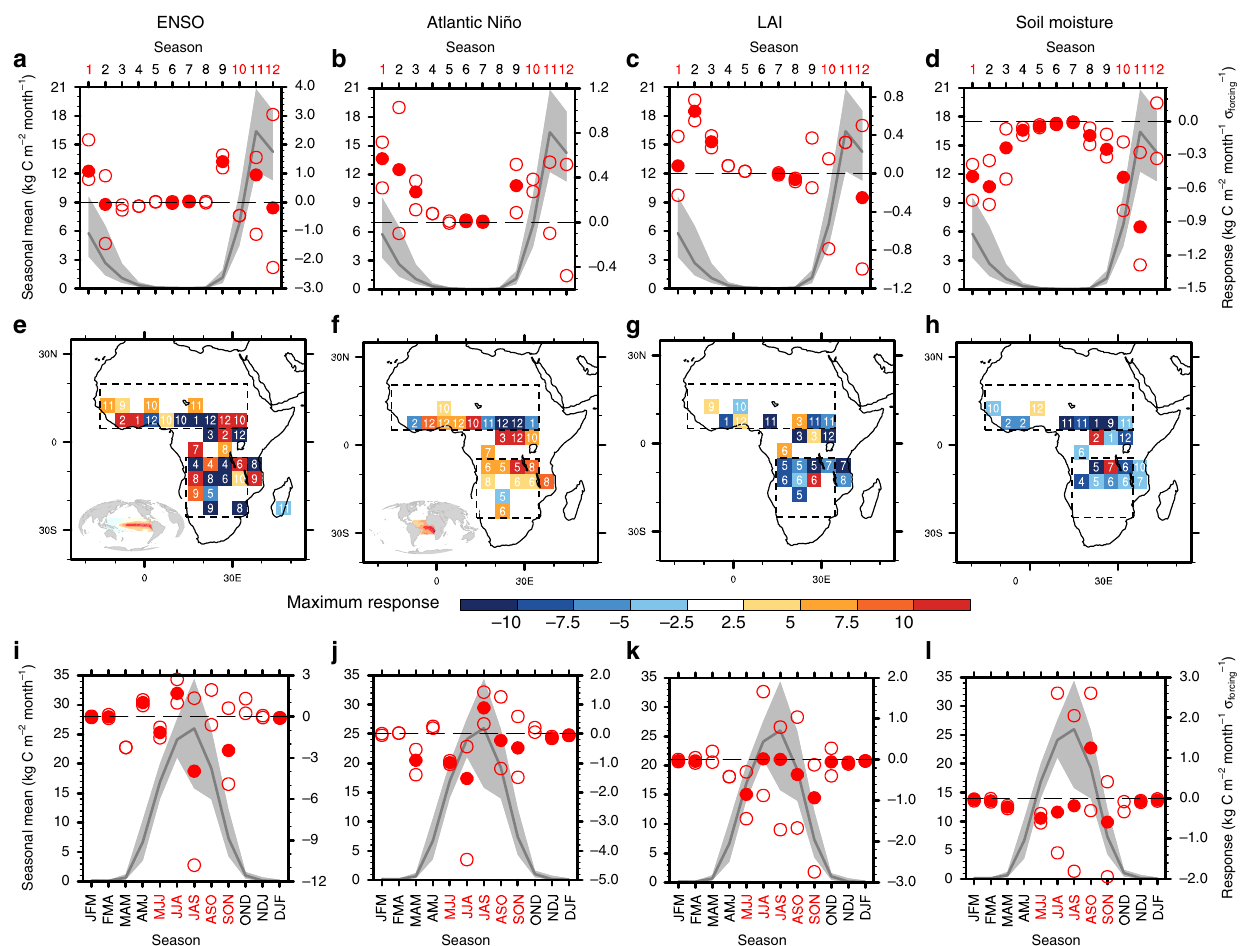
Fig. 2 African fi re response to key environmental drivers. Response of African fi re carbon emissions to the most important environmental forcings is assessed by the Stepwise Generalized Equilibrium Feedback Assessment (SGEFA). These forcings include a , e , i El Niño-Southern Oscillation (ENSO), b , f , j Atlantic Niño mode, c , g , k leaf area index (LAI), and d , h , l soil moisture. Seasonal cycle of the a – d northern and i – l southern African regional average climatology, with line and shading representing mean and interannual standard deviation, referring to the left y -axis (unit: kg C m − 2 month − 1 ), and response to the corresponding forcing, with the fi lled and open circles indicating the multi-dataset average and 10th and 90th percentiles, referring to the right y -axis (unit: kg C m − 2 month − 1 σ forcing − 1 ). A missing fi lled circle in a – d and i – l indicates insigni fi cant multi-dataset average response to the speci fi c forcing. e – h Spatial distribution of the season (number representing each 3-month season, e.g., 1 for January – March) and sign and magnitude (color) of the maximum absolute response to the corresponding forcing. The spatial patterns of the ENSO and Atlantic Niño forcing are demonstrated in the inserted global map in e and f , respectively. In these inlets, positive and negative anomalies in sea-surface temperature are represented by red and blue colors, respectively. The boxes in e – h indicate the geographic location of the currently assessed northern and southern African ecoregions. Only statistically signi fi cant responses ( p < 0.1) are shown here. In i – l , labels on the x -axis stand for 3-month seasons, e.g., JFM for January, February, and March. The fi re-active season is highlighted with red labels on the x